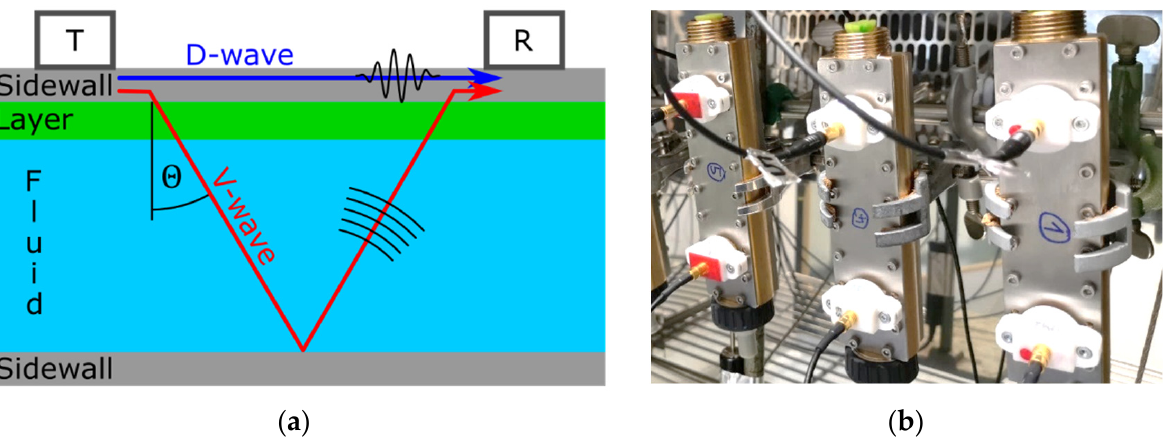
Figure 1. ( a ) Schematics of the setup including an ultrasound transmitter (T), receiver (R), the direct (D) and indirect (V) propagation paths in the Lamb wave flow meter as investigated in this article. ( b ) The studied ultrasonic flow meters in the climate